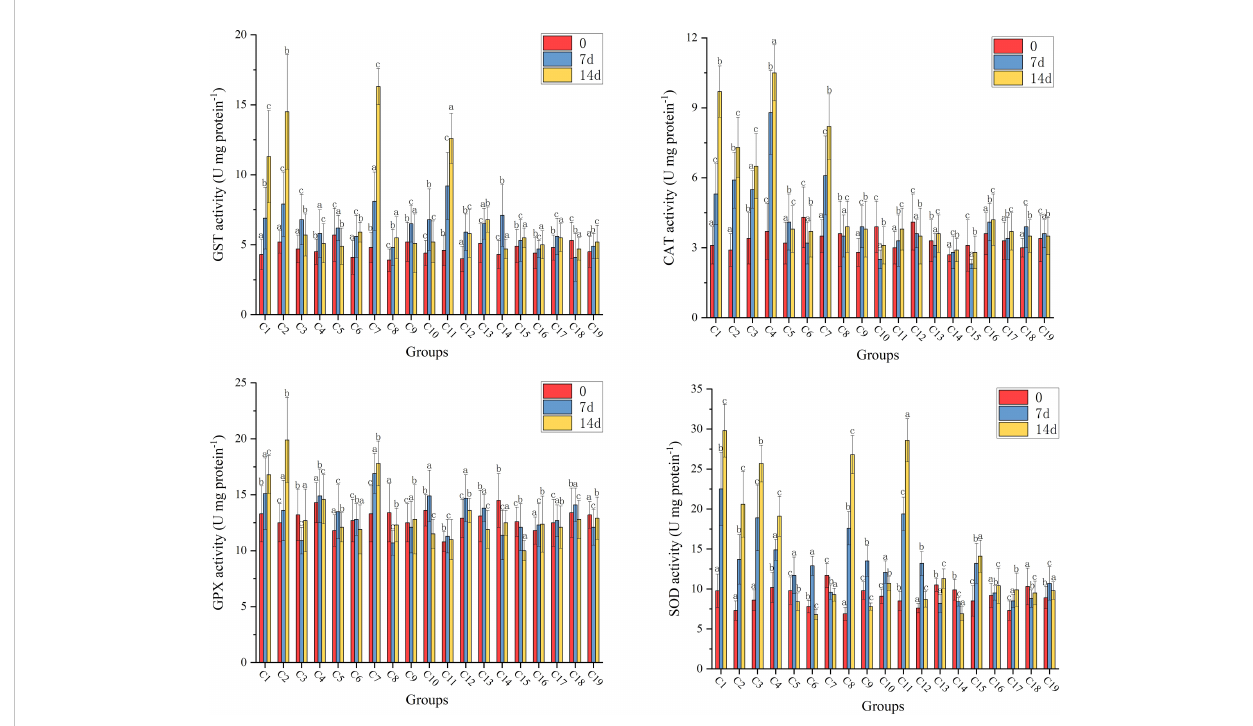
FIGURE 2 The results of the four antioxidant enzymes activity (GST, CAT, GPX and SOD) analysis in hepatopancreas of shrimps at 0-, 7- and 14-days. Data are means for three assays and presented as the means ± SD, different letters indicate signi fi cant differences ( p <